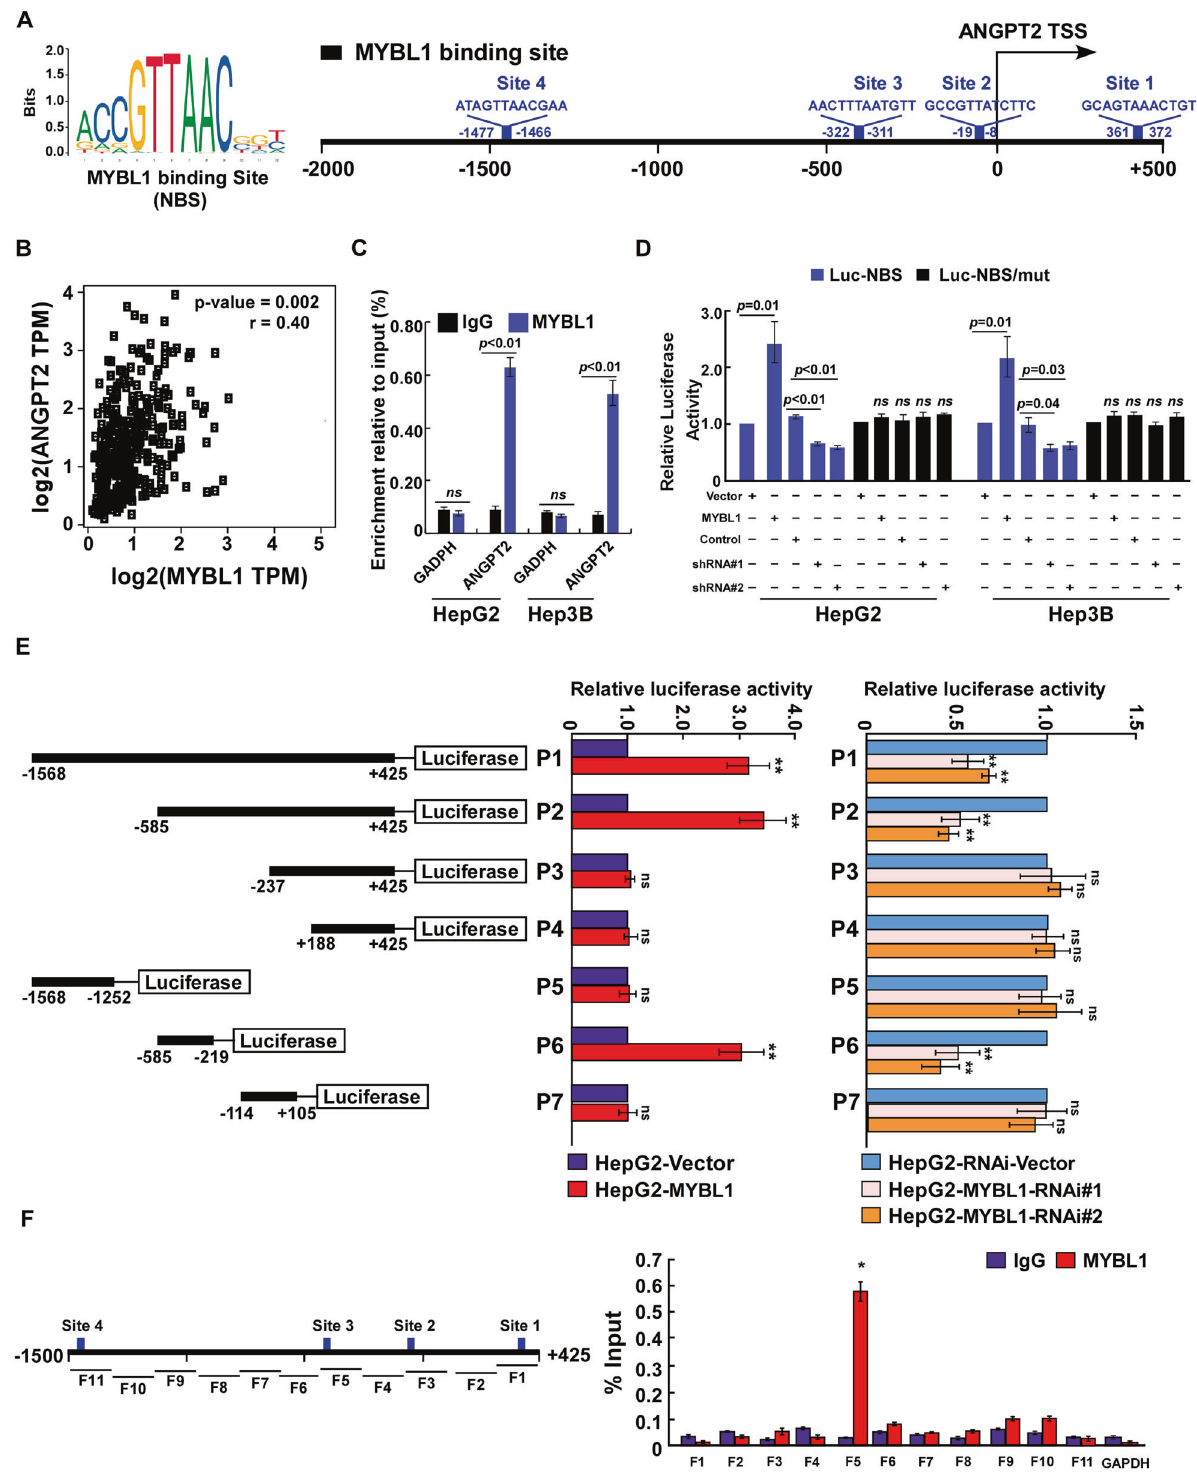
Fig. 4 MYBL1 upregulates ANGPT2 in HCC cells. A Four potential MYBL1 binding sites were predicted in the promoter of ANGPT2 using the JASPAR database. TSS: Transcription start site. B Correlation analysis of MYBL1 and ANGPT2 in HCC cells. C ChIP analysis of the association between MYBL1 and ANGPT2 gene transcripts in HCC cells. D Relative promoter luciferase activities of ANGPT2 in the indicated HCC cells. E Left panel: schematic illustration of the cloned fragments of the human ANGPT2 promoter. The promoter region was cloned as six fragments (P1-P7). Right panel: transactivation activity of the indicated serial ANGPT2 promoter fragments in the indicated cells. F Analysis of the physical association of regions of the ANGPT2 promoter with MYBL1 using a CHIP assay. Left panel, schematic illustration of PCR-ampli fi ed fragments of ANGPT2 promoter. Right panel, CHIP assays were performed in HCC cells using an MYBL1 antibody to identify ANGPT2 promoter regions bound to MYBL1. IgG was used as a negative control. Error bars represent the mean ± SD of three independent experiments. * P < 0.05.